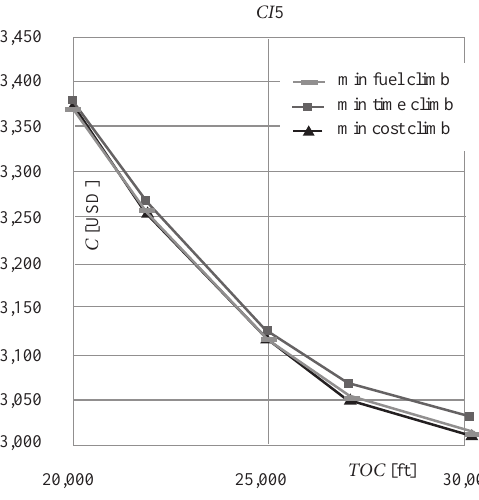
Fig. 11. Comparison of en route flight total costs for three types of climb techniques, CI = 5